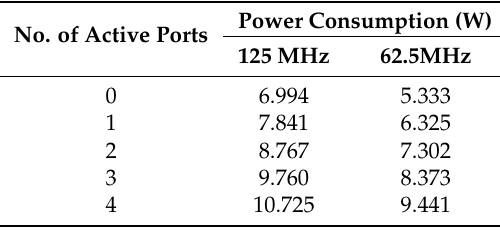
Table 3. Impact of operating frequency and the number of active ports on the power consumption of the reference router (RR).